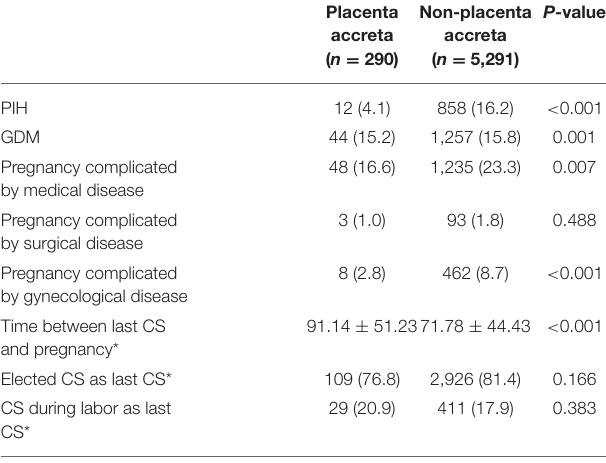
TABLE 2 | Univariable analyses between the placenta accreta group and the non-placenta accreta group in the training set.